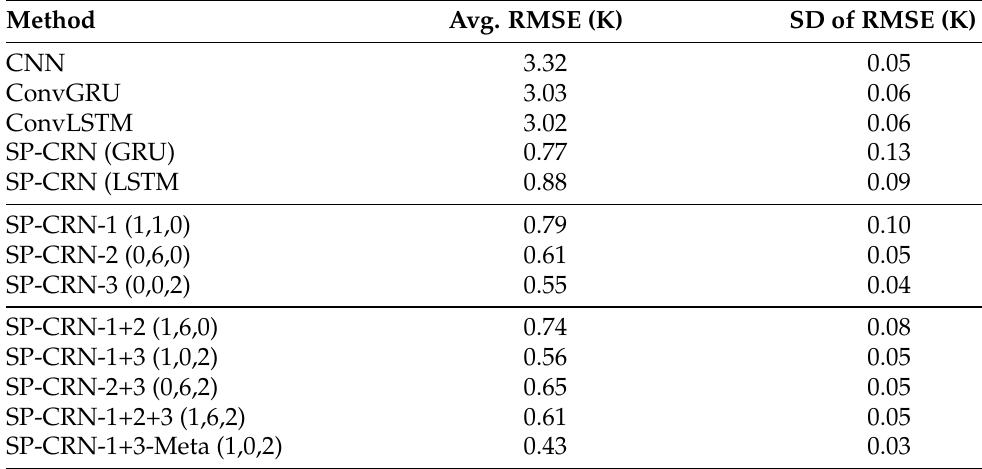
Table 4. Evaluation of different settings on the SST prediction for SP-CRN and comparison